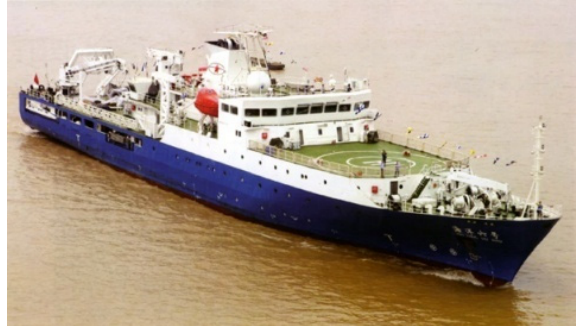
Figure 10. Support vessel “Hai Yang Liu Hao”.